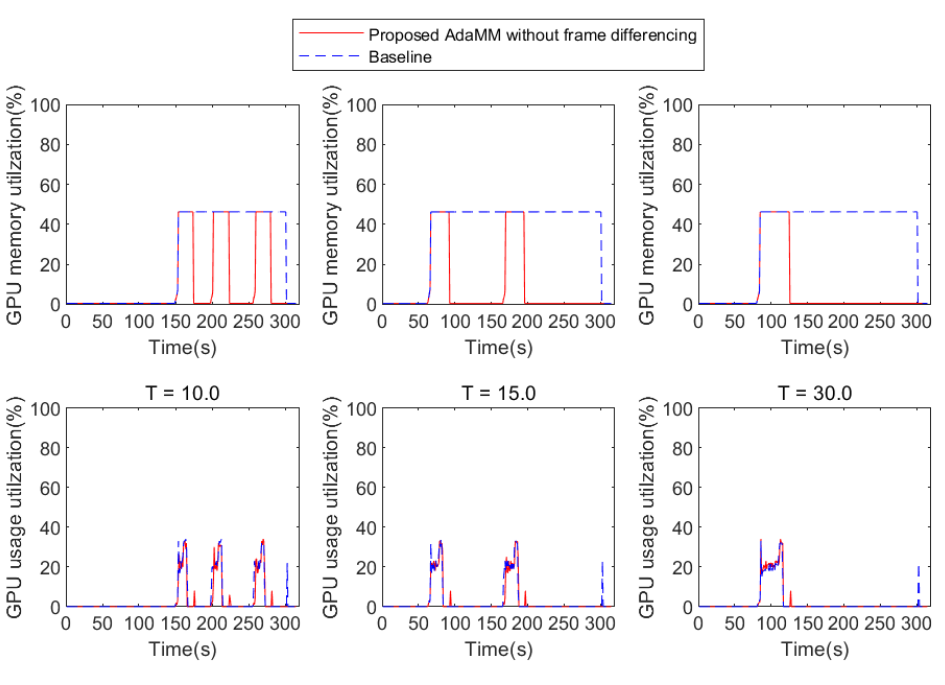
Figure 8. GPU usage and memory utilization based on T when X = 10% (in the case of θ m = 10).